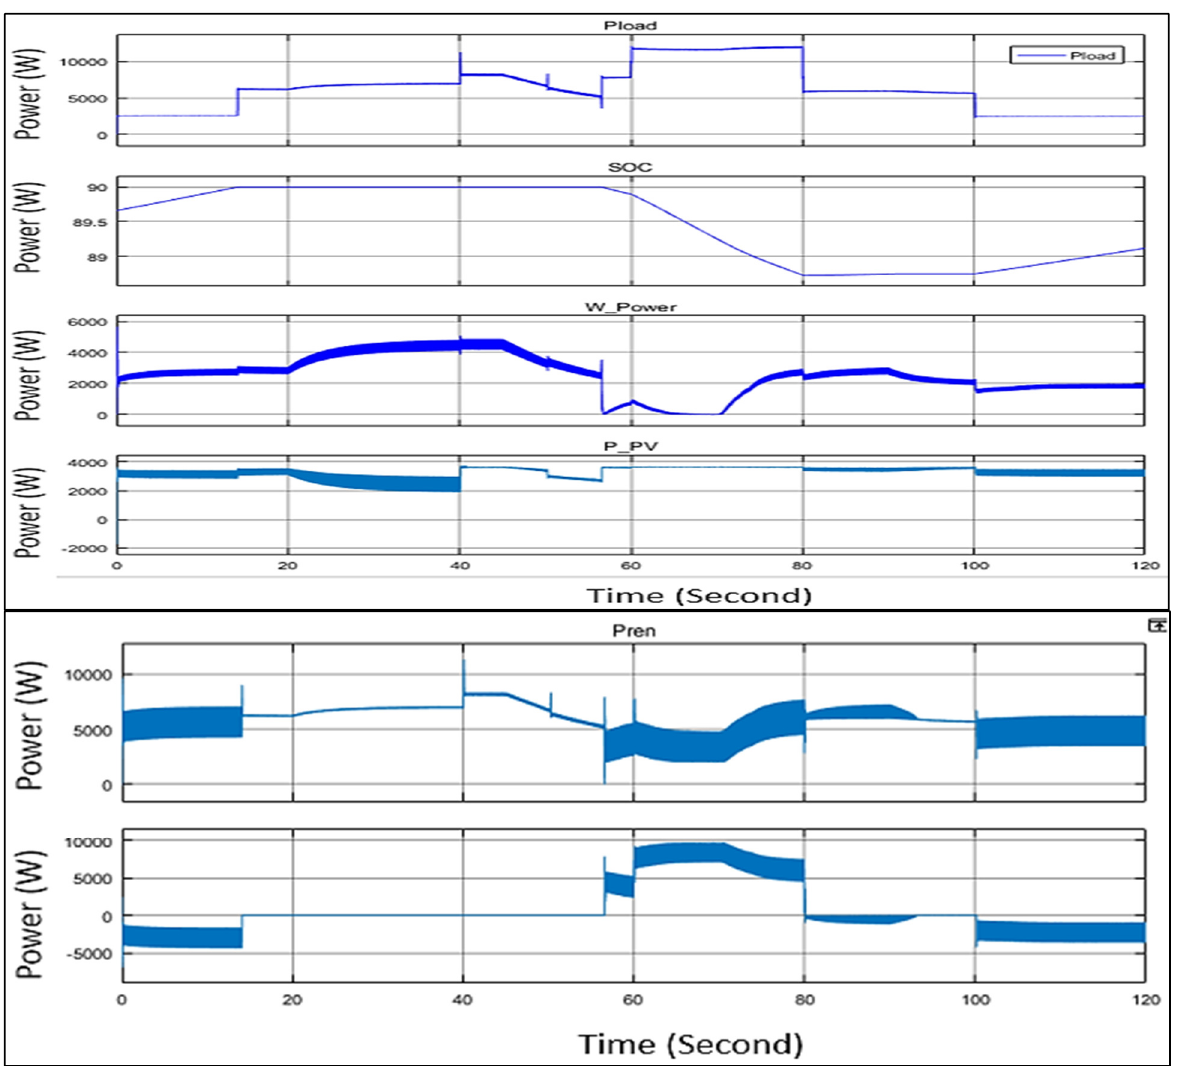
Fig. 8: Power Load, SOC of Battery, Wind Power, Photovoltaic Power, Power Generated by Renewable Energy and Battery Power